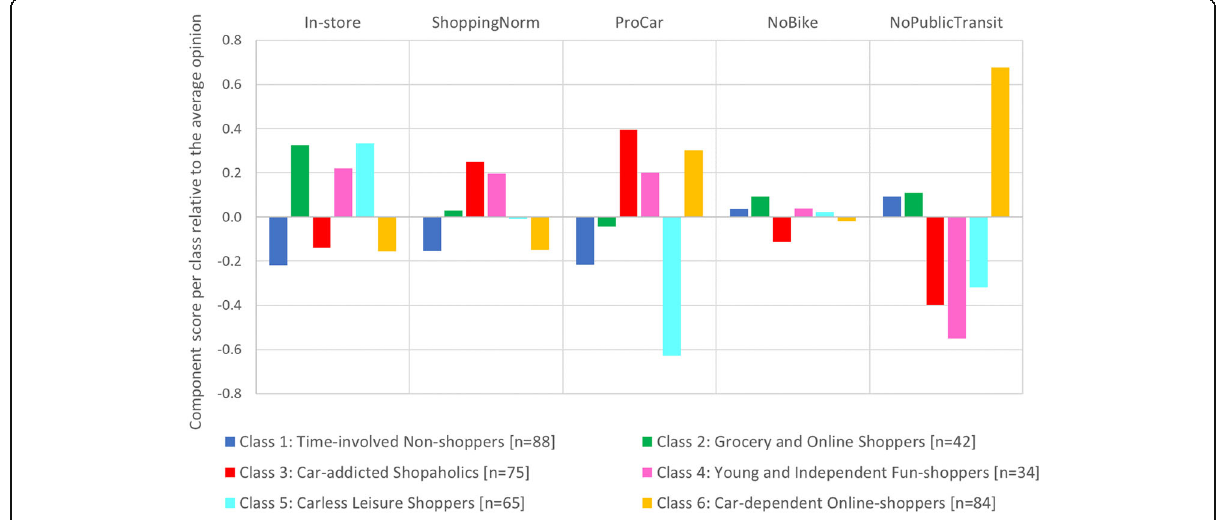
Fig. 3 Components (z-transformed) representing attitudes of the six